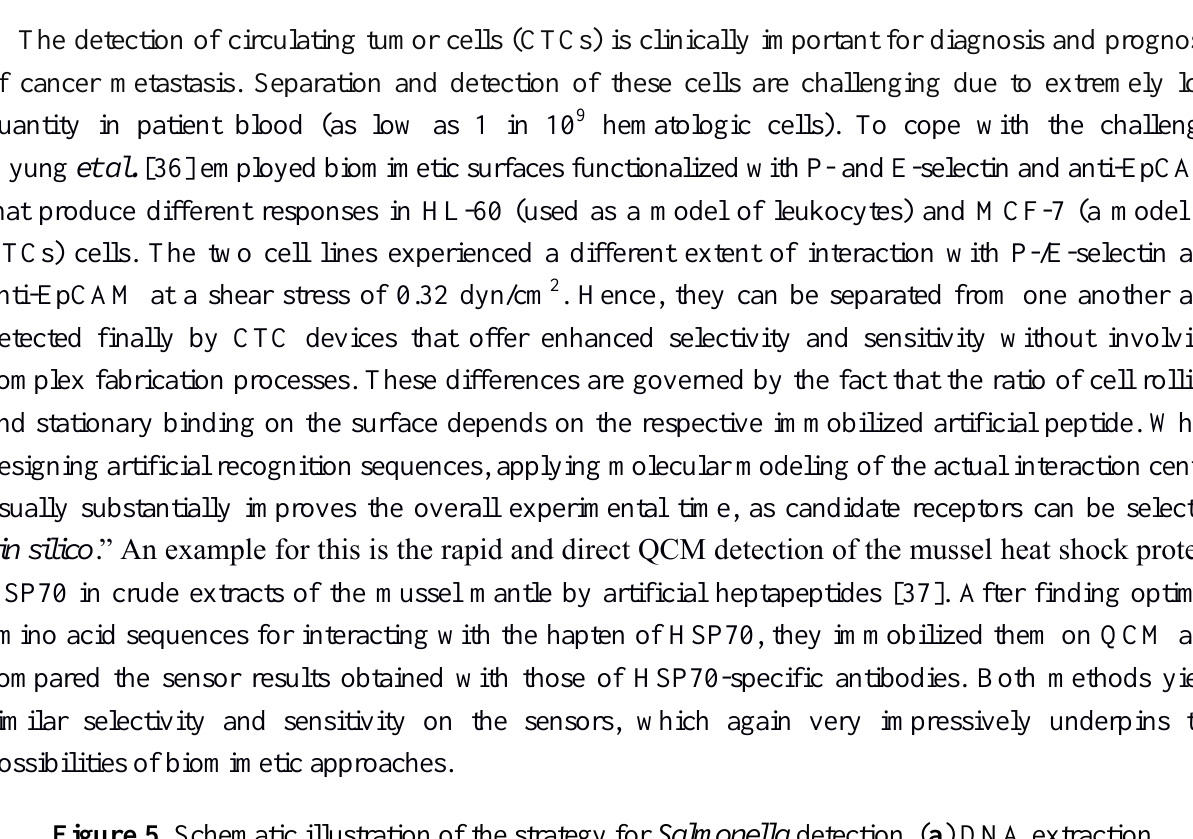
Figure 5. Schematic illustration of the strategy for Salmonella detection. ( a ) DNA extraction from Salmonella cells and amplification using the second step-asymmetric PCR ( b ) Probe immobilization and interaction with PCR amplicons. Reprinted with permission from [38], © 2012